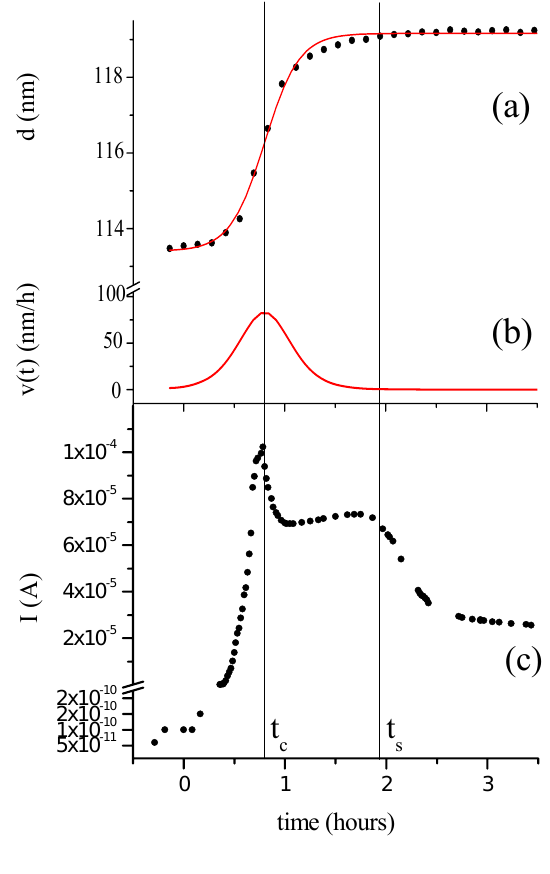
Figure 6. (a) Evolution of the parameter d of a 110 nm thick TiPc time when exposed to an NO 50 ppm gas flow. (b) Derivative of d vs t. (c) Evolution of 2 the current as a function of time as in (a)